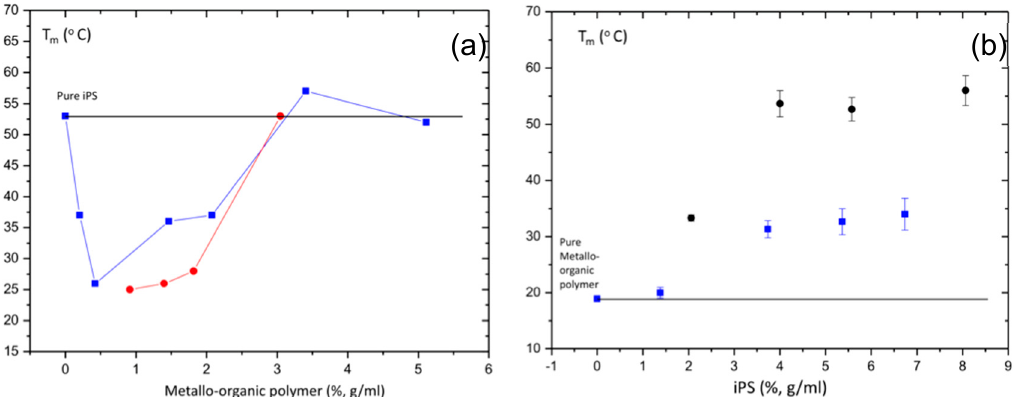
Figure 8. ( a ) Melting temperature (Tm) as a function of metallo-organic polymer concentration (%, g / mL) for pure metallo-organic polymer gel (red circle) and iPS / metallo-organic polymer hybrid gel with a fixed iPS concentration of 4%, g / mL (blue squares). ( b ) Melting temperature (Tm) as a function of iPS concentration (%, g / mL) for pure iPS polymer gel (black circle) and iPS / metallo-organic polymer hybrid gel with a fixed metallo-organic polymer concentration of 1.4%, g / mL (blue squares).